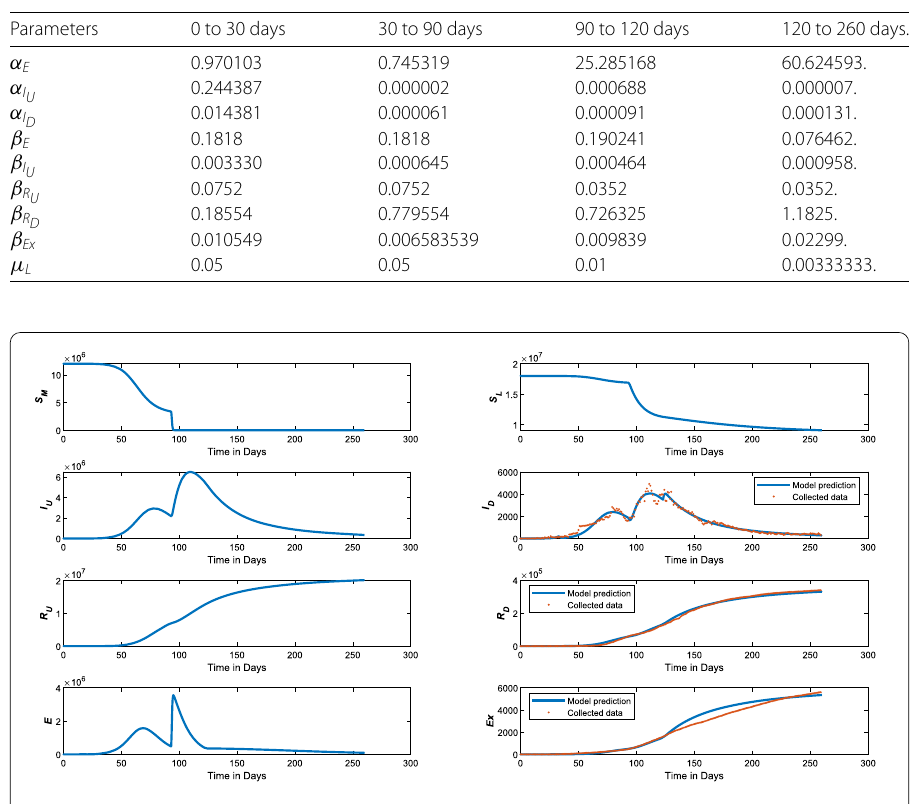
Figure 3 Model prediction taking into account different stages of the control measures imposed by the authorities and the corresponding epidemiological data, including the number of individuals diagnosed with ( COVID-19 ), recovered and dead, collected from the Saudi Arabian Ministry of Health, see “https://covid19.moh.gov.sa/”